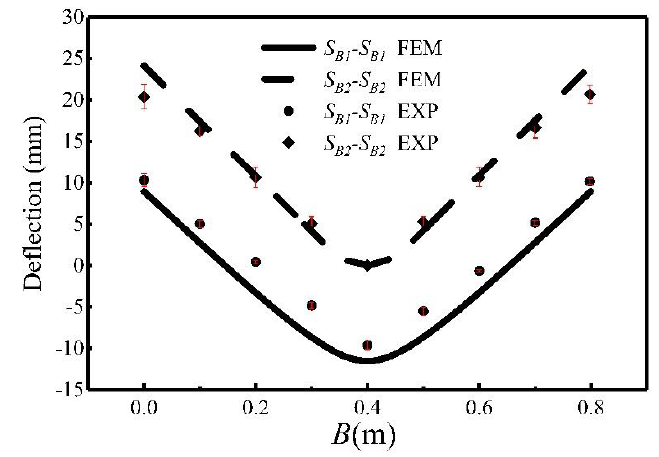
Figure 10. Comparison of plate transversal bending deformation.